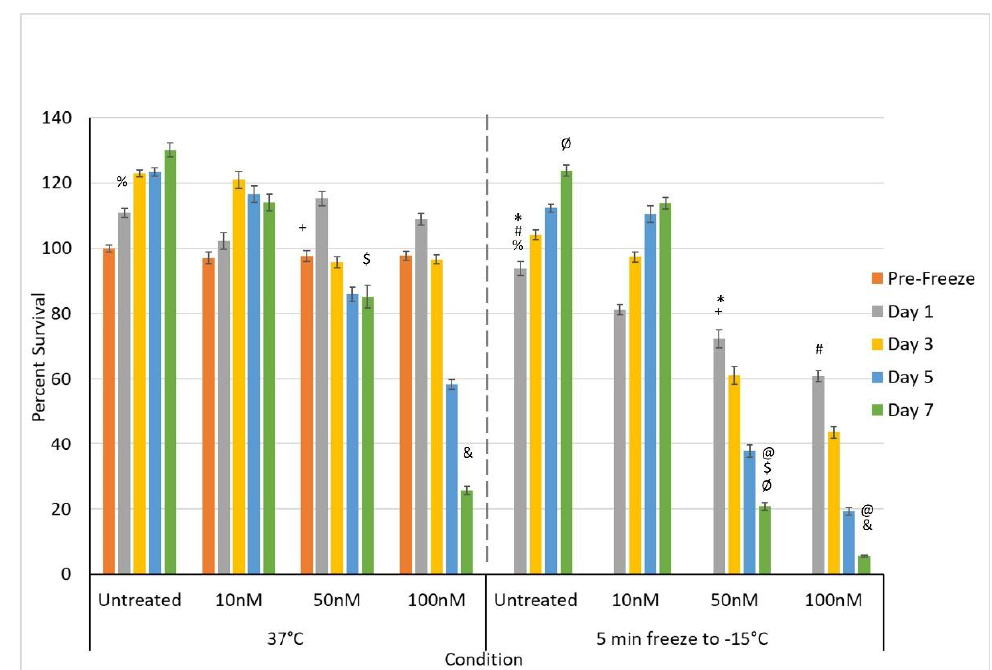
Figure 4. Effect of adjunctive gemcitabine pretreatment at sub-clinical dose in combination with freezing on PaCa cell survival. Samples were pre-treated with 10, 50, or 100 nM gemcitabine for 48 h and drug removed prior to freezing to −15 °C. Sample viability was compared to freezing and gemcitabine treatment alone. Data reveal a significant improvement in cell death following the combination of 50 and 100 nM gemcitabine and −15 °C, whereas 10 nM gemcitabine and −15 °C samples showed no benefit. Importantly, the combination of 100 nM gemcitabine and −15 °C yielded complete cell death by day 7 (@, #, $, %, &, *, +, Ø = p < 0.01).